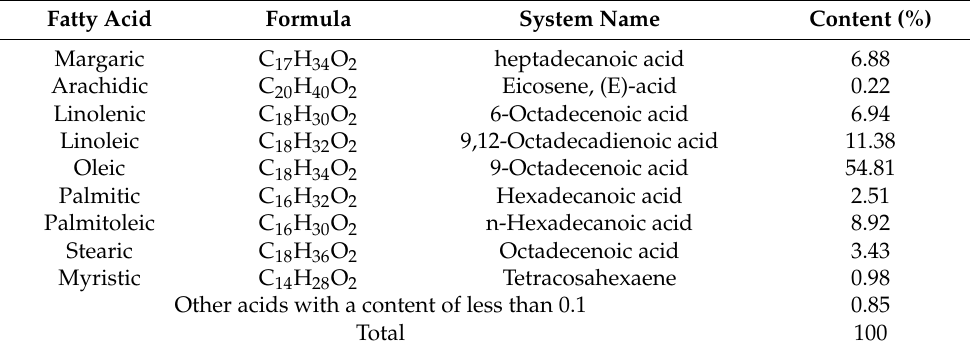
Table 3. Fatty acids of the waste frying oil.